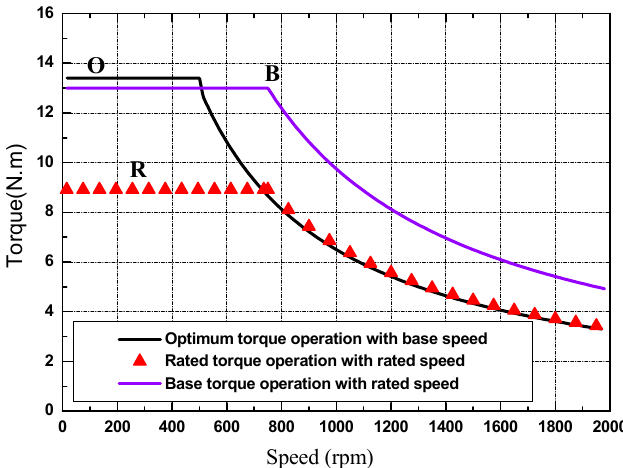
Figure 14. Electric vehicle (EV) motor torque/speed patterns.